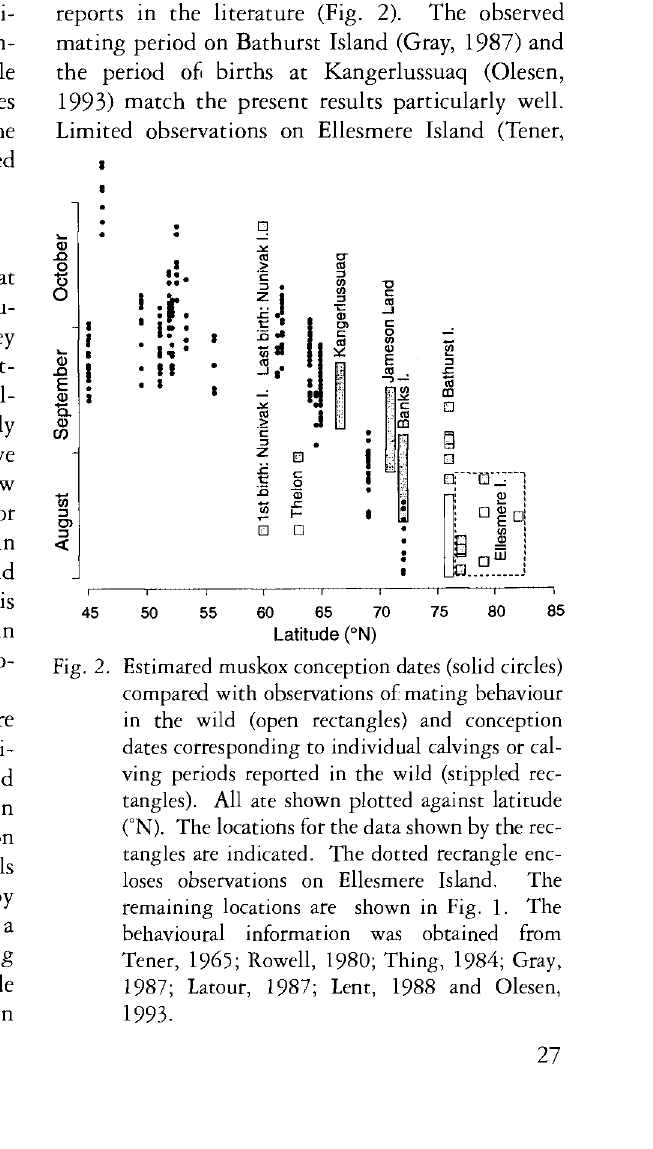
Fig. 2. Estimared muskox conception dates (solid circles) compared with observations of mating behaviour in the wild (open rectangles) and conception dates corresponding to individual calvings or cal ving periods reported in the wild (stippled rec tangles). All ate shown plotted against latitude (°N). The locations for the data shown by the rec tangles are indicated. The dotted recrangle enc loses observations on Ellesmere Island. The remaining locations are shown in Fig. 1. The behavioural information was obtained